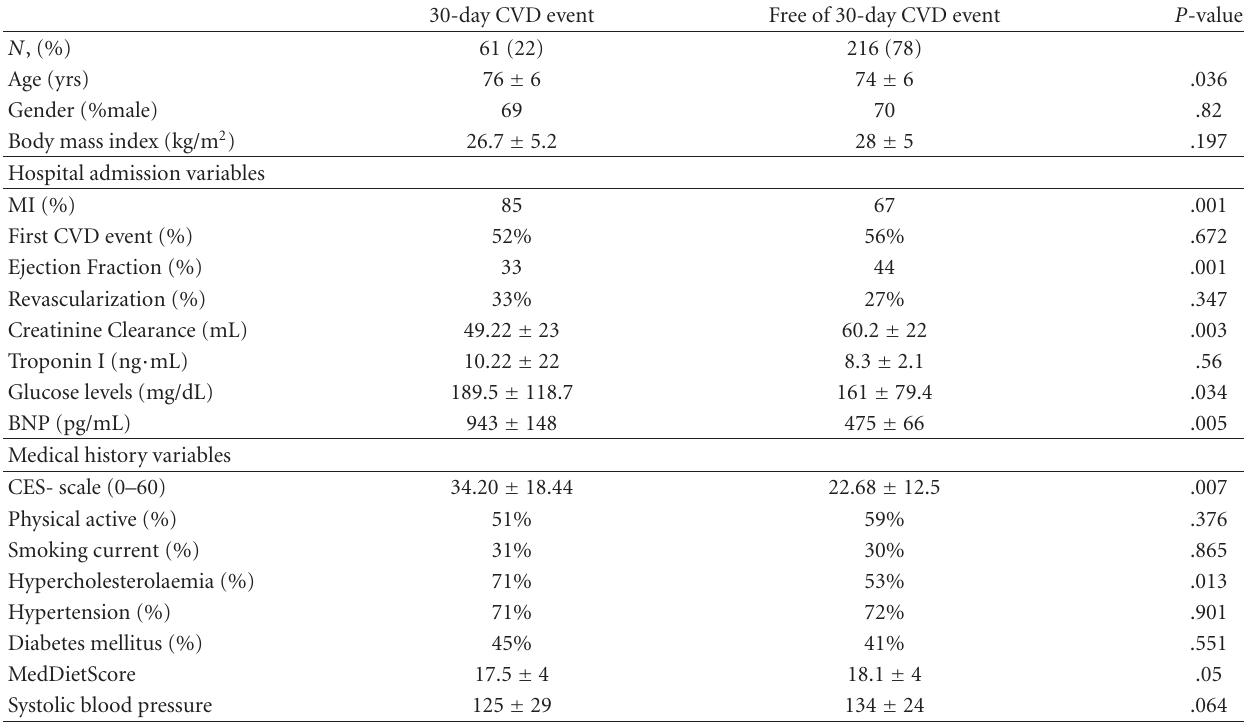
Table 1: Clinical, biochemical, and lifestyle characteristics of ACS elderly patients ( n = 277), according to the development of 30-day CVD events.